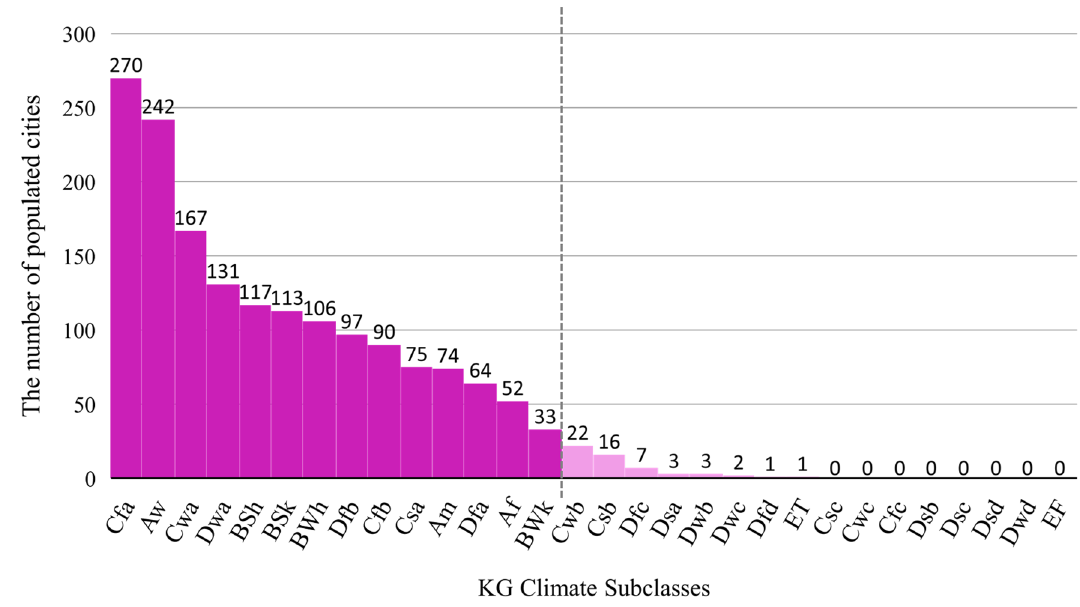
Figure 9. The number of the top populated cities in each Köppen–Geiger climate subclass.